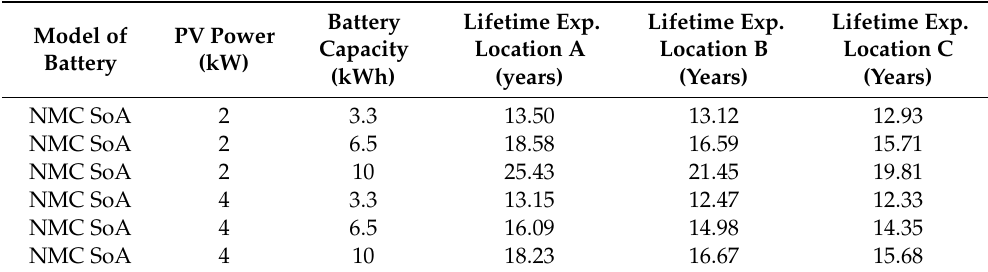
Table 5. Lifetime expectancy results for the NMC state-of-the-art battery pack installed at household 2 and analyzed at the three di ff erent